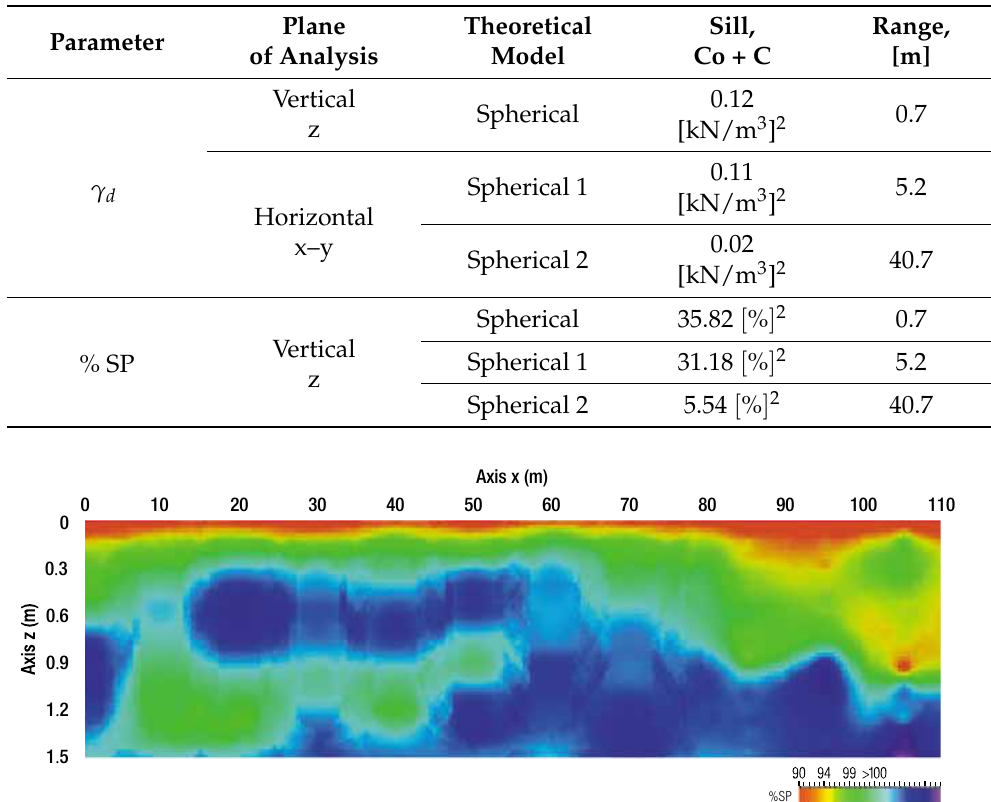
Table 10. Results for γ d and %SP semivariogram modeling in vertical and horizontal directions for full survey grid.